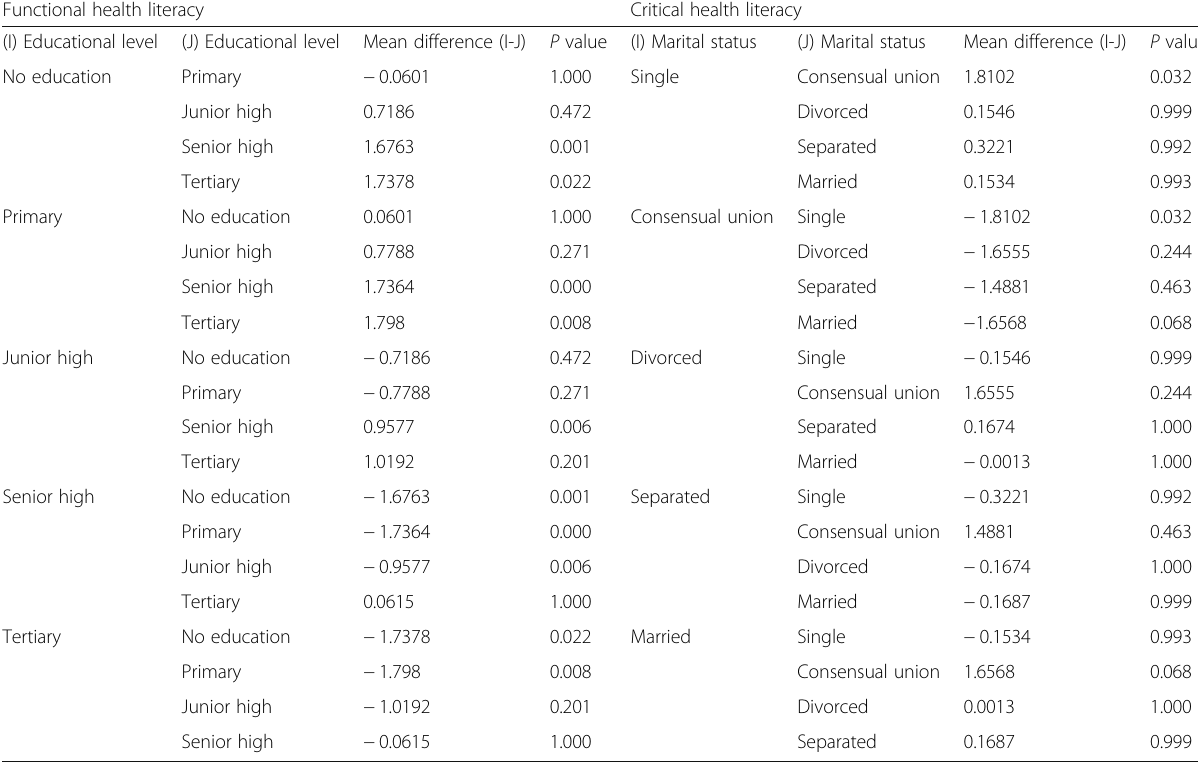
Table 2 Univariate analysis of variance of the relationship between demographic characteristics and health literacy scores: multiple comparisons (post hoc tests)